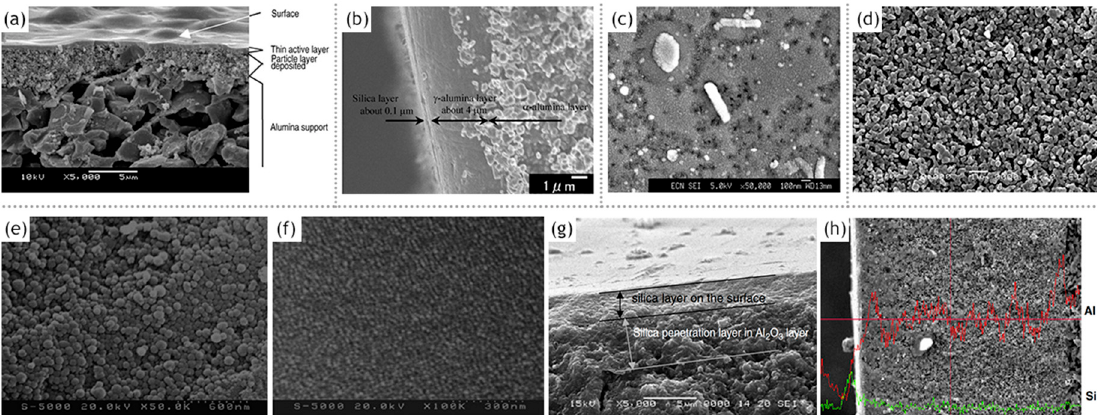
Figure 7. ( a ) Typical SEM micrograph of amembrane cross section, adapted from [2], with permission from Copyright (2002), Elsevier Science B.V. ( b ) FE-SEM image for the cross section of phenyl functionalized silica membrane, adapted from [1], with permission from Copyright (2011), Elsevier